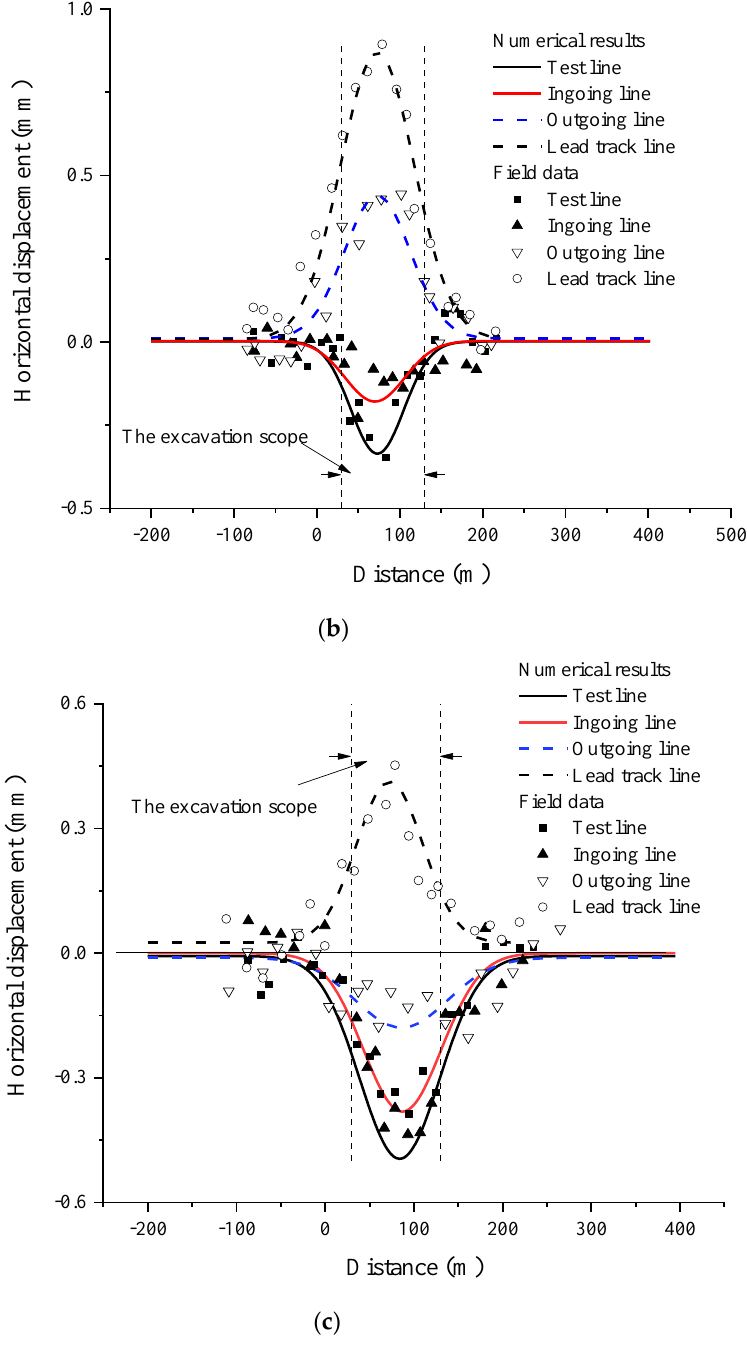
Figure 10. Numerical results and field data of horizontal displacement of the tunnel: ( a ) stage 3, ( b ) stage 4, ( c ) stage 5.